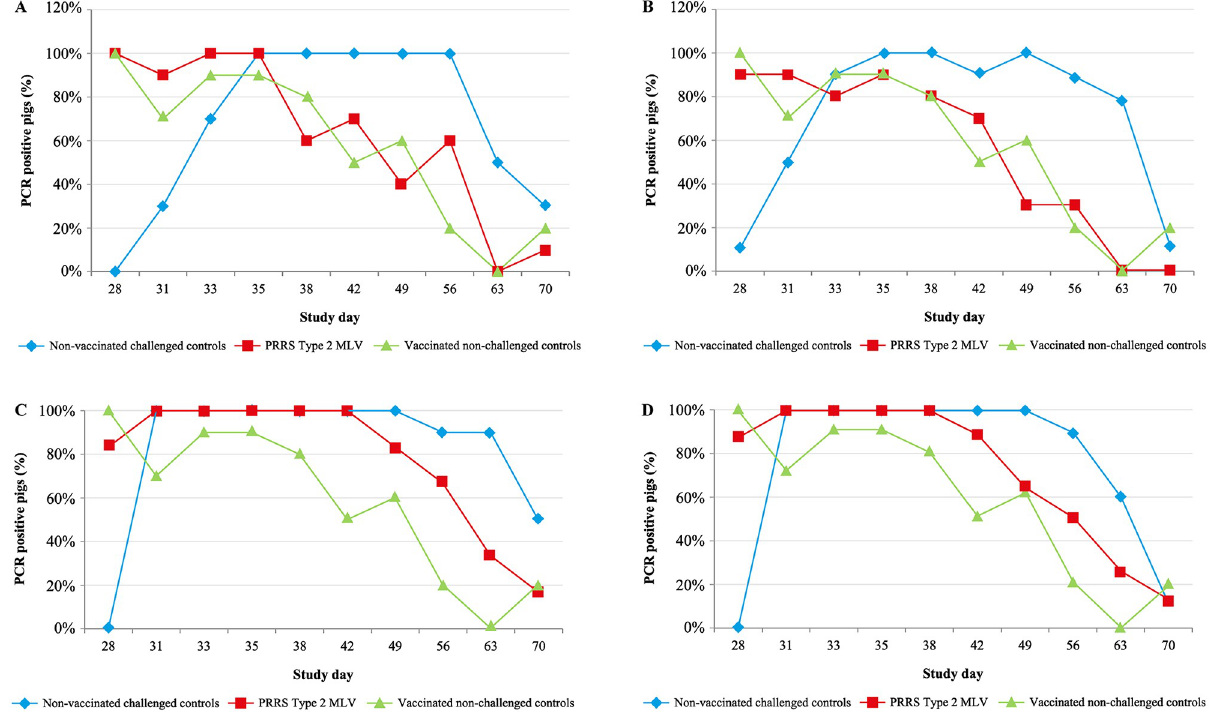
Fig 1. Viraemia in pigs challenged with PRRSV. a) Percentage of PCR positive pigs challenged with < 1.5 log virulent PRRSV strain. b) Percentage of PCR positive pigs challenged with 2 log virulent PRRSV strain. c) Percentage of PCR positive pigs challenged with 3 log virulent PRRSV strain. d) Percentage of PCR positive pigs challenged with 4 log virulent PRRSV strain. MLV = modified-live virus; PCR = polymerase chain reaction; PRRS = porcine reproductive and respiratory syndrome; PRRSV = porcine reproductive and respiratory syndrome virus; TCID 50 = 50% tissue culture infectious dose.